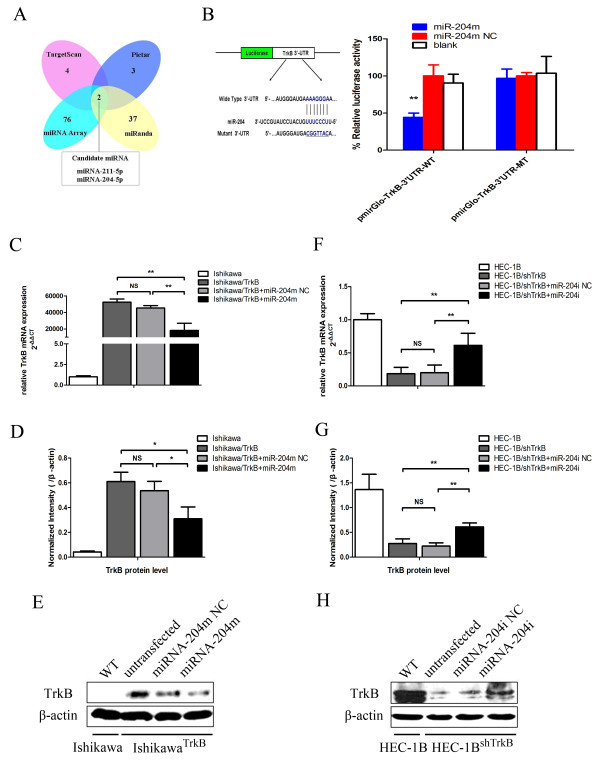
MiR-204-5p is a negative modulator of TrkB expression in endometrial cancer cells. (A) Schema of selection of candidate miRNAs (miR-211-5p and miR-204-5p) targeting TrkB using three online target-prediction programs (TargetScan, Pictar and miRanda) and the microarray data. (B) Left panel: Schema of the construction of pMIRGLO-TrkB-3′UTR-WT and pMIRGLO-TrkB-3′UTR-MT vectors. The mutant binding site is underlined. Right panel: 293 T cells were co-transfected with pMIRGLO-TrkB-3′UTR-WT or pMIRGLO-TrkB-3′UTR-MT and miR-204-5p mimic (miR-204 m) or scrambled miRNA control (miR204m NC). Luciferase activities are shown as mean ± SD of at least three independent experiments done in triplicate. **P < 0.01. (C) IshikawaTrkB cells were transfected with miR-204 m NC or miR-204 m. TrkB expression was examined by RT-PCR and normalized against β-actin. Data are shown as mean ± SD of at least three independent experiments.** P < 0.01; NS P > 0.05. (D) Cells were transfected as in (C) and TrkB expression was determined by Western blotting assays, which were quantified by densitometry of triplicate experiments (* P < 0.05; NS P > 0.05). β-actin was included as an internal control. Representative blots are shown in (E). (F) HEC-1BshTrkB cells were transfected with a miR-204 inhibitor (miR-204i) or a scrambled control inhibitor (miR-204i NC) or with miR-204 inhibitor (miR-204i). TrkB expression was examined by RT-PCR and normalized against β-actin. Data are shown as mean ± SD of at least three independent experiments.** P < 0.01; NS P > 0.05. (G) Cells were transfected as in (F) and TrkB expression was determined by Western blotting assays, which were quantified by densitometry of triplicate experiments (** P < 0.01; NS P > 0.05). β-actin was included as an internal control. Representative blots are shown in (H).